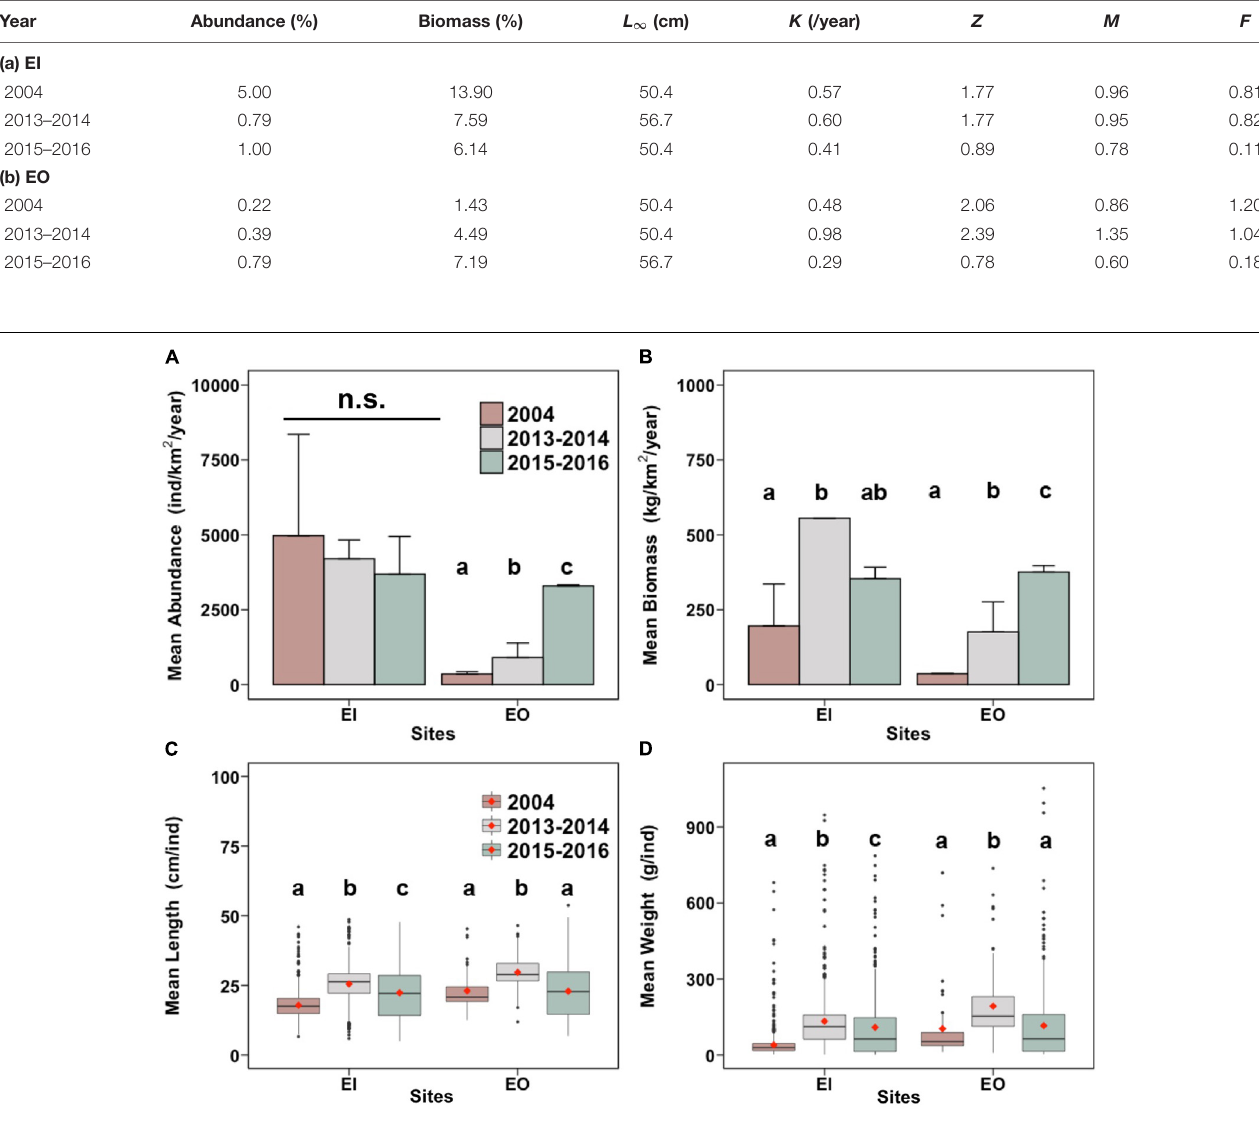
TABLE 1 | Percentages of abundance and biomass (% over total fish abundance/biomass in the catch) and von Bertalanffy growth function (VBGF) growth parameters: asymptotic length (L ∞ ), the growth rate (K), total mortality (Z), natural mortality (M), and fishing mortality (F) for Platycephalus indicus collected in the inner Tolo Channel (EI), outer Tolo Channel (EO) waters of Hong Kong from January 2004 to December 2004 (2004; before the trawl ban), June 2013 to May 2014 (2013–2014; immediately after the trawl ban), and June 2015 to May 2016 (2015–2016; 3.5 years after the trawl ban).